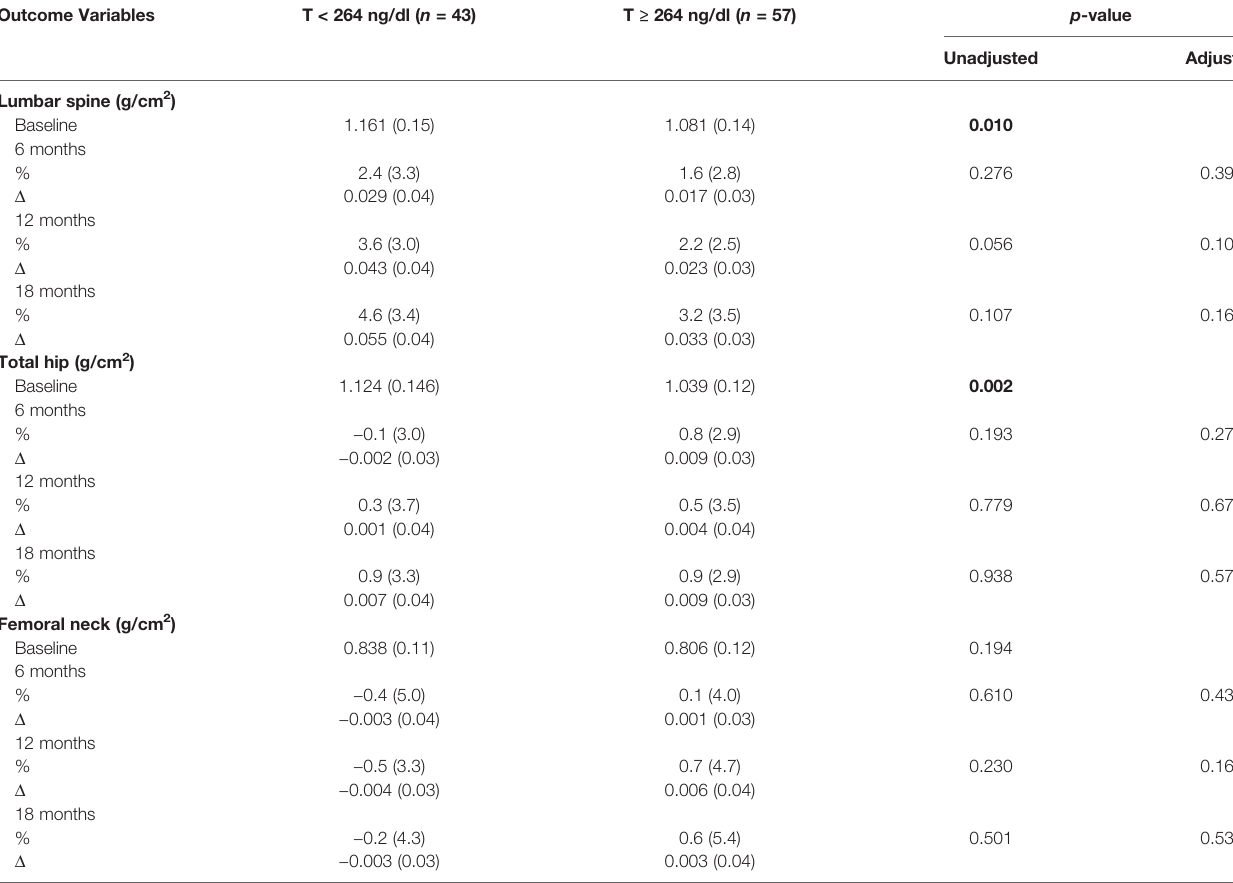
TABLE 4 | Changes in bone mineral density with testosterone therapy from baseline to 18 months between the two groups. Outcome Variables